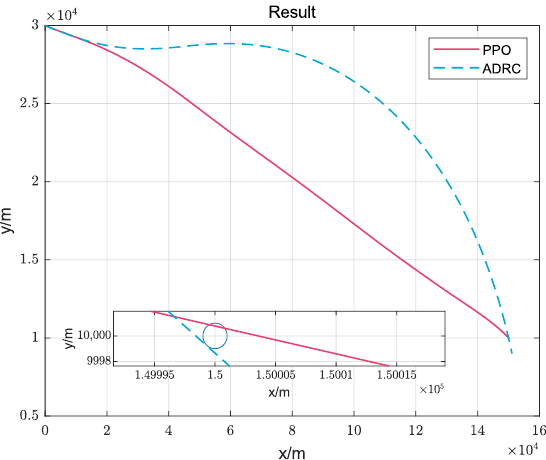
Figure 5. Trajectory when no fault occurs.